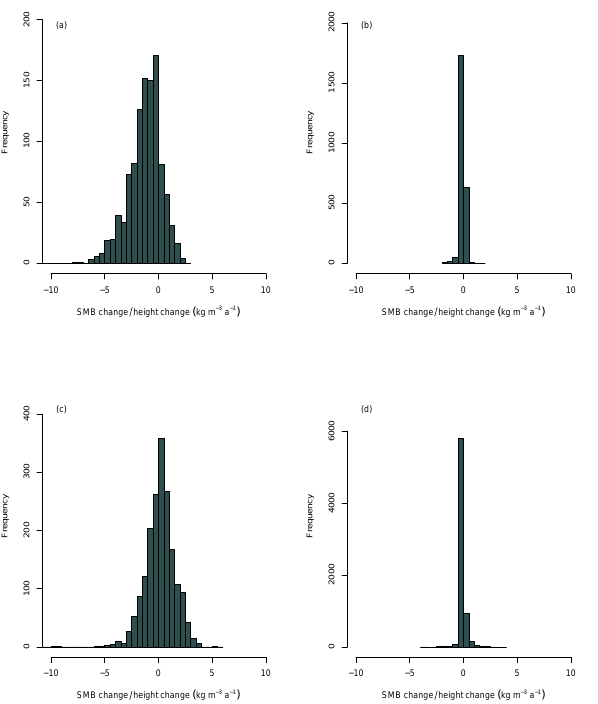
Fig. 6. Histograms of the ratio ∆S / ∆h for grid cells north (top row) and south (bottom) of 77 ◦ N, divided into grid cells with SMB in both the control and perturbed experiments less than zero (left column) and greater than or equal to zero (right). Data with height change | ∆ h | < 25m are excluded.